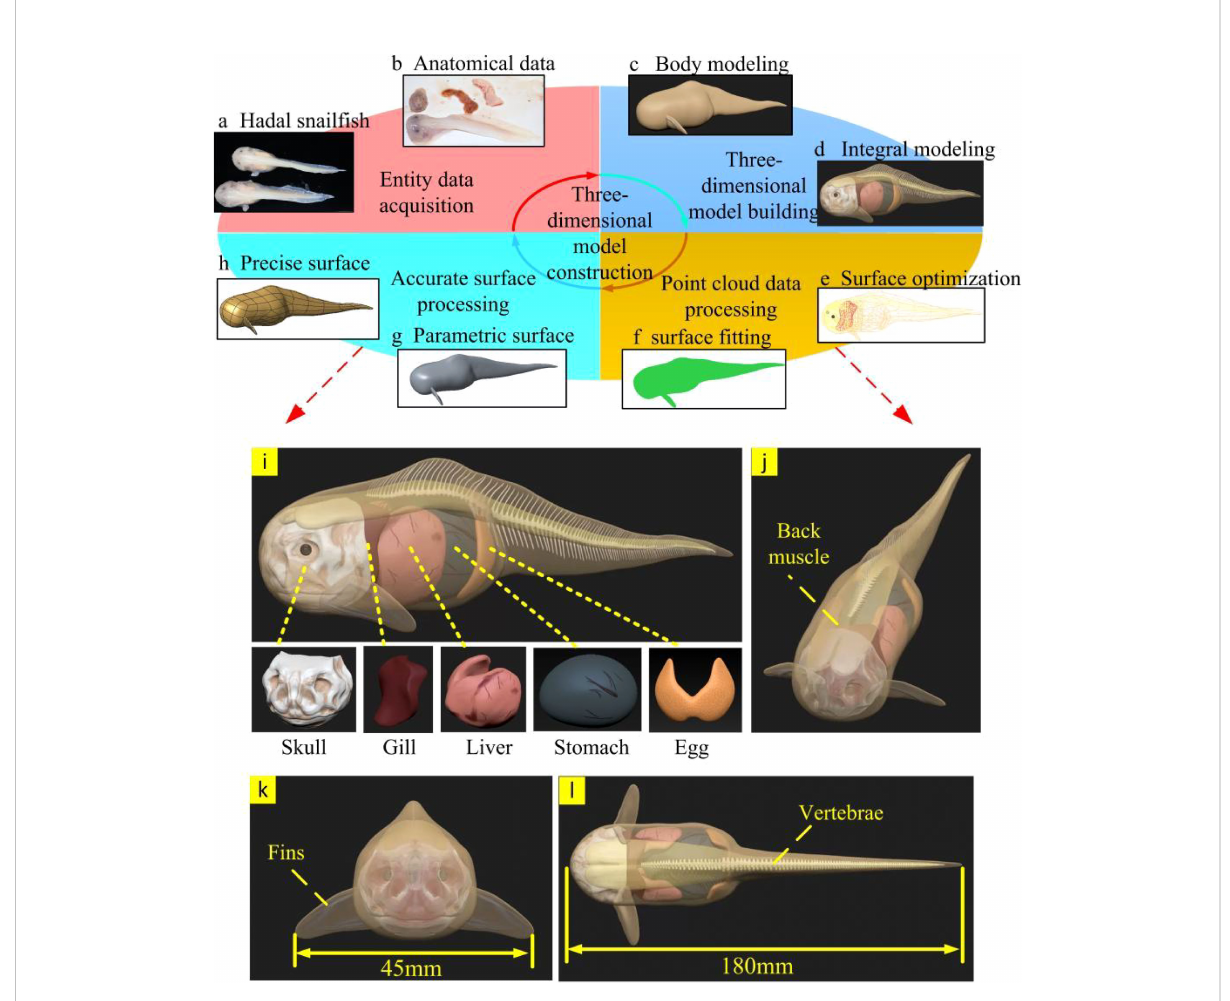
FIGURE 4 Modeling process and structure of tissues and organs of hadal snail fi sh (A – H) construction of a 3D model of hadal snail fi sh; (I) tissue and organ distribution of hadal snail fi sh; (J – L) three views of hadal snail fi